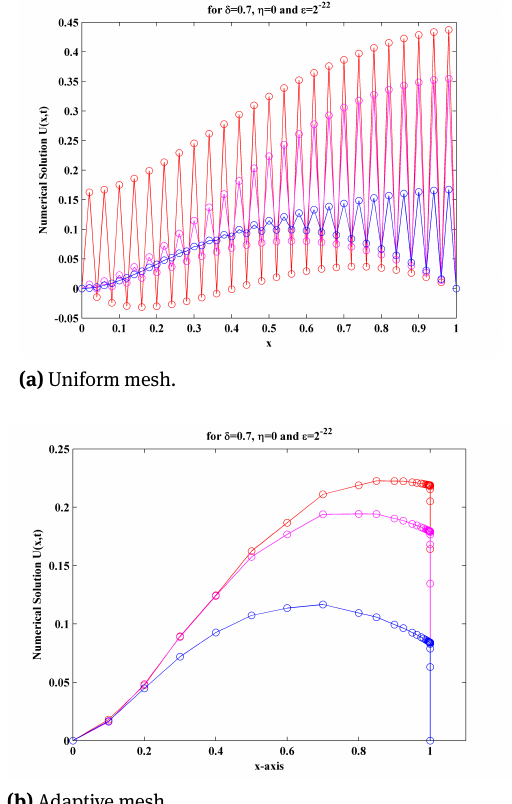
Fig. 5: Numerical solution of example 5.2, using uniform mesh and adaptive mesh for three different time level with ε = 2 −22 , δ = 0.7 , η = 0 , M=50 and